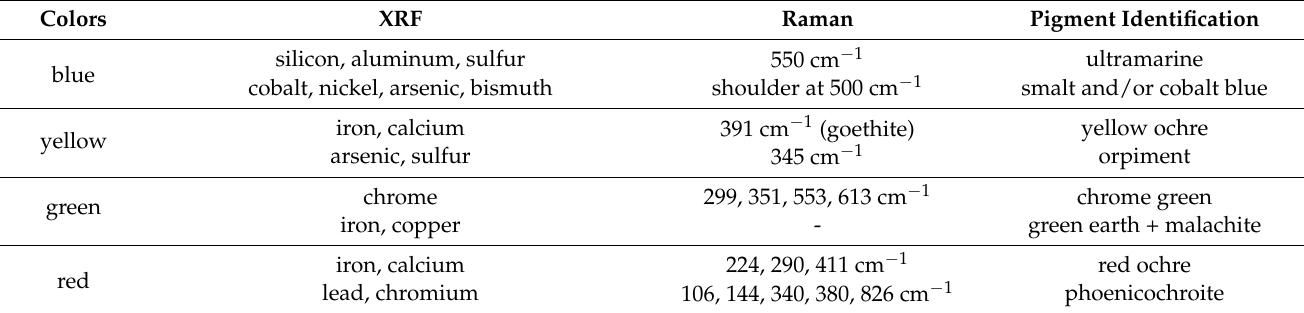
Table 1. Summary of the identified pigments by means of XRF and Raman Spectroscopy.